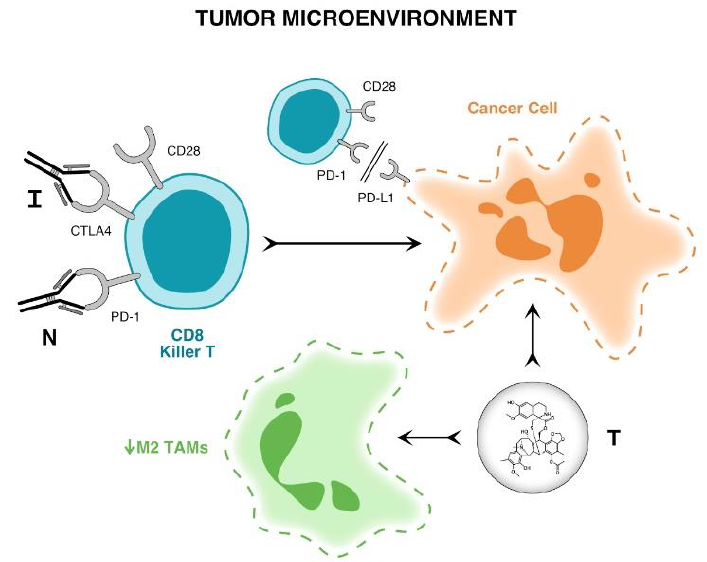
Figure 1. Graphic illustration of the mechanism of action of Ipilimumab, Nivolumab and Trabectedin in the tumor microenvironment. Ipilimumab (I) blocks the CTLA 4 receptor and nivolumab (N) blocks the PD-1 receptor on T cells which then block the PD1- PD-L1 interaction on tumor cells. Trabectedin (T) not only kills cancer cells but depletes the tumor microenvironment of growth promoting or M2 macrophages. The combined effect of these three drugs is sustained T cell activation, resulting in tumor lysis, inhibition of tumor growth or tumor eradication.